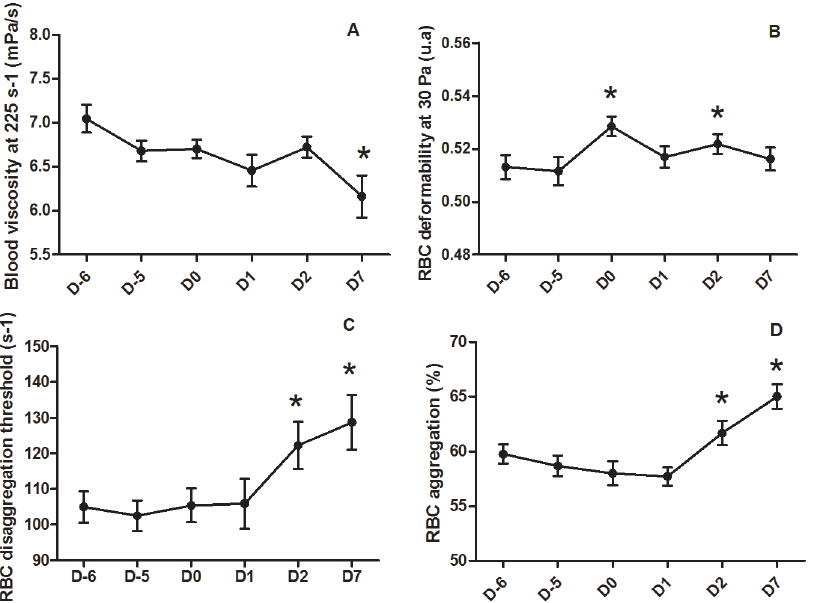
Figure 3. Effect of exposure to 32 6 C on hemorheological properties in growing pigs. Mean 6 standard error. * means that daily value is significantly different (P , 0.05) from values at 24 u C (i.e., mean of D-6 and D-5).